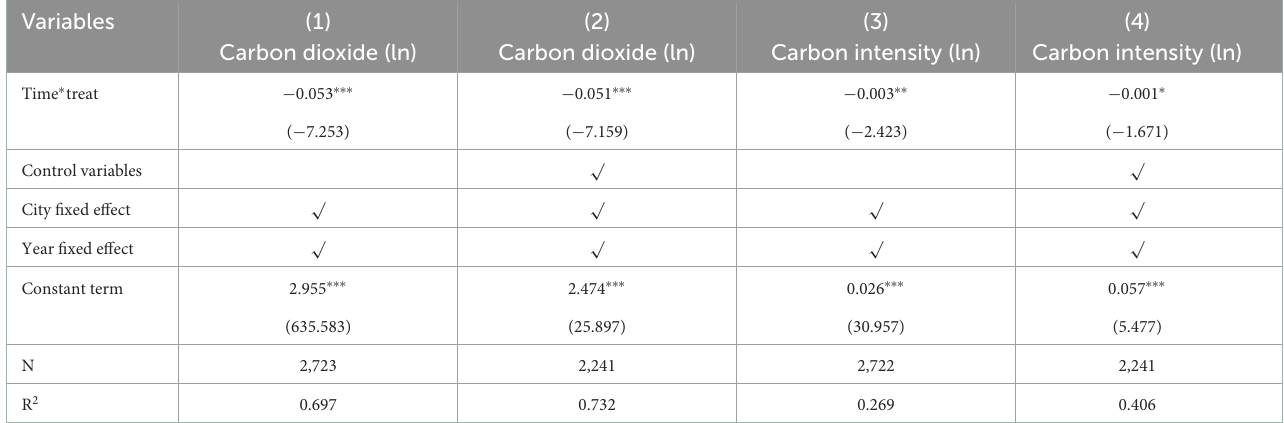
TABLE 5 Substitute dependent variable